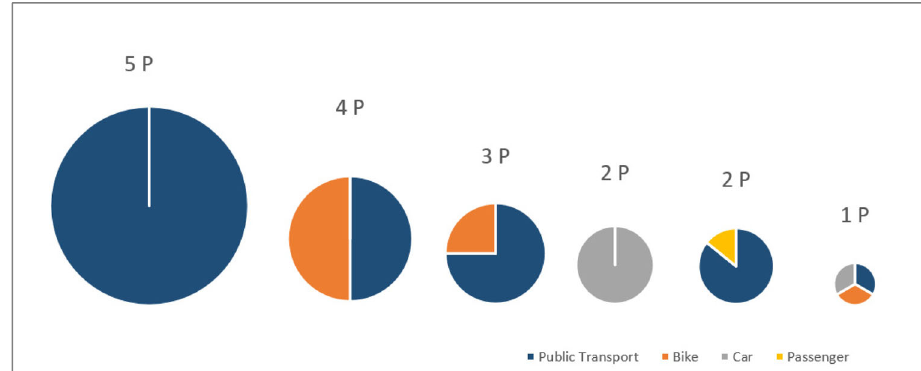
Fig. 4 Regularly used transport modes of